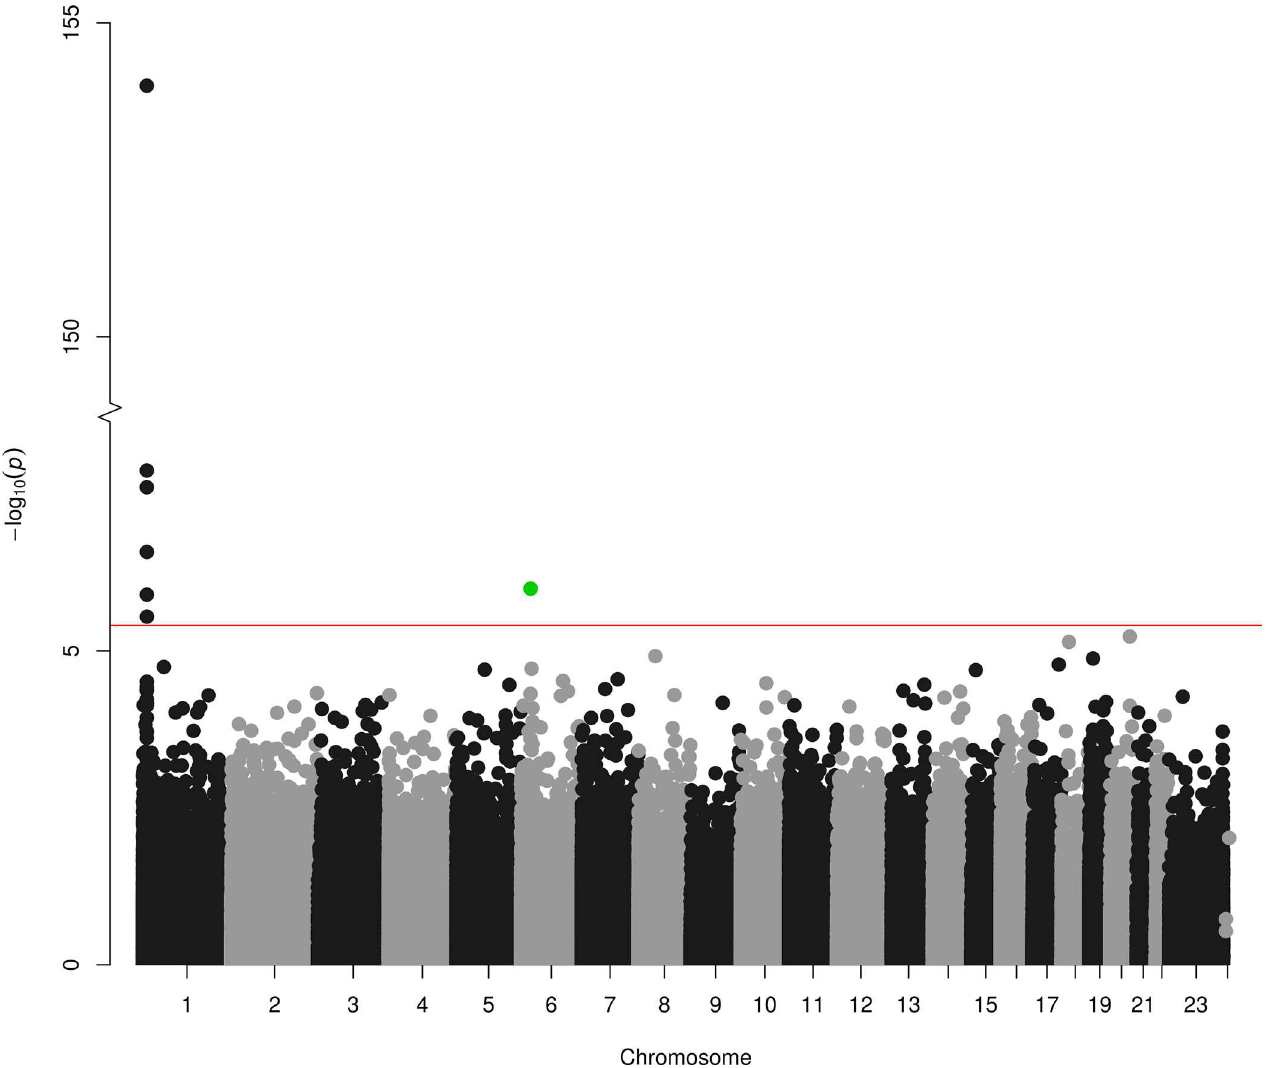
Fig 1. Manhattan plot. Association betweenMTHFR 677C > T(rs1801133) and genome-wide DNA methylationin 9,894 samples,with 35 cis - meQTLs at chromosome 1 (black/grey) and 1 trans -meQTL at chromosome6 (green)with FDR < 0.05. [Table a in S6 Table, Table a in S7 Table and S8 Table] CpGs for the GRS model [Fig 2]. The λ was 1.01 for the MTHFR 677C > T SNP and 0.92 for GRS [S1 Fig].